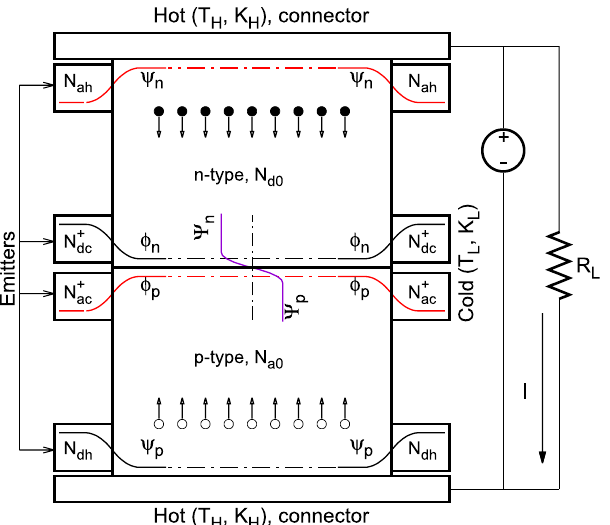
Figure 1. Diagram of the proposed new thermocouple design. The external carrier injectors or emitters surround the leg exterior surfaces. These emitters are labled by their doping densities and are enlarged for better